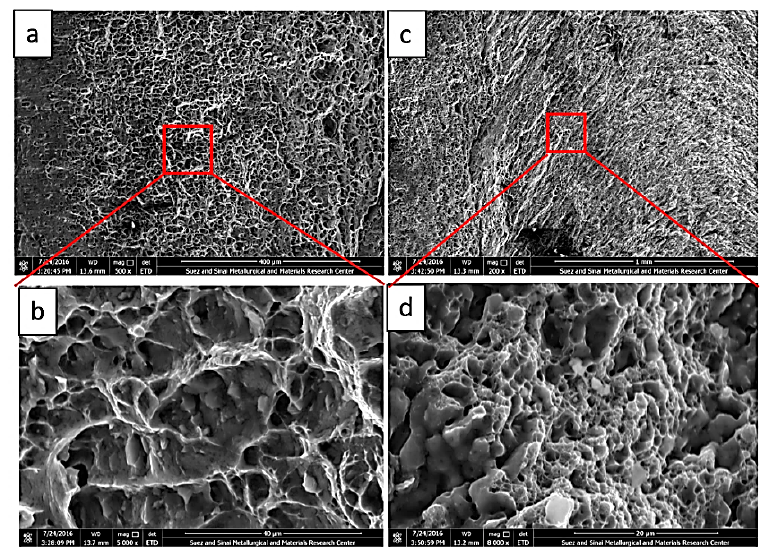
Figure 14. ( a , c ) SEM images of the fracture surface of tensile test samples of AA7020/AA5083 joint of AA7020 AS, 500 rpm–20 mm/min; ( b , d ) show the shape deep dimples.